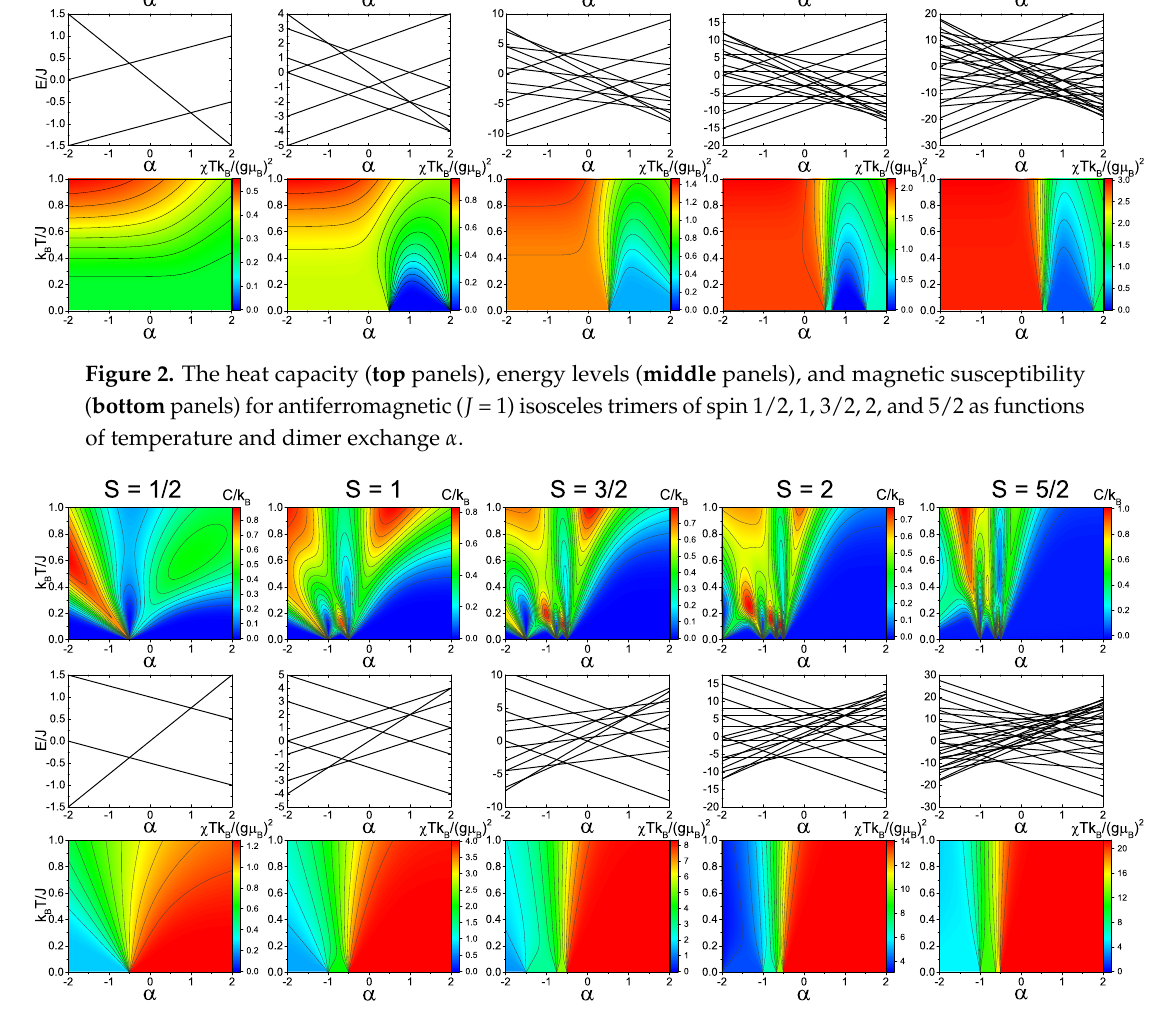
Figure 3. The heat capacity ( top panels), energy levels ( middle panels), and magnetic susceptibility ( bottom panels) for ferromagnetic ( J = − 1) isosceles trimers of spin 1/2, 1, 3/2, 2, and 5/2 as functions of temperature and dimer exchange α